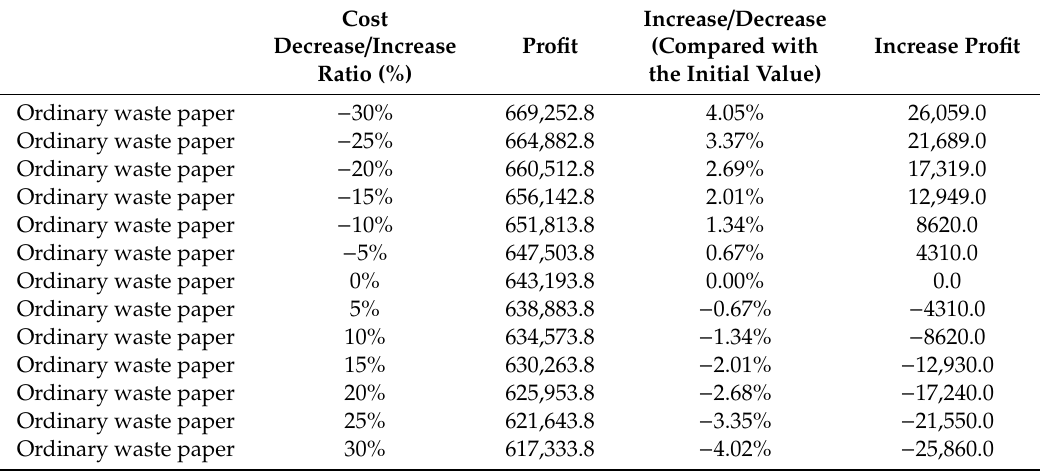
Table 5. Sensitivity analysis on the cost of ordinary waste